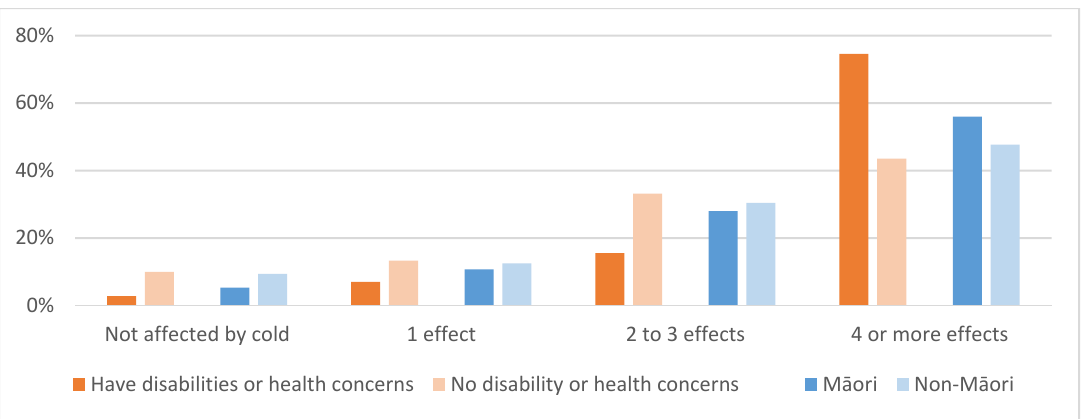
Figure 2. Comparison across demographic groups of students reporting consequences of cold in the dwelling.